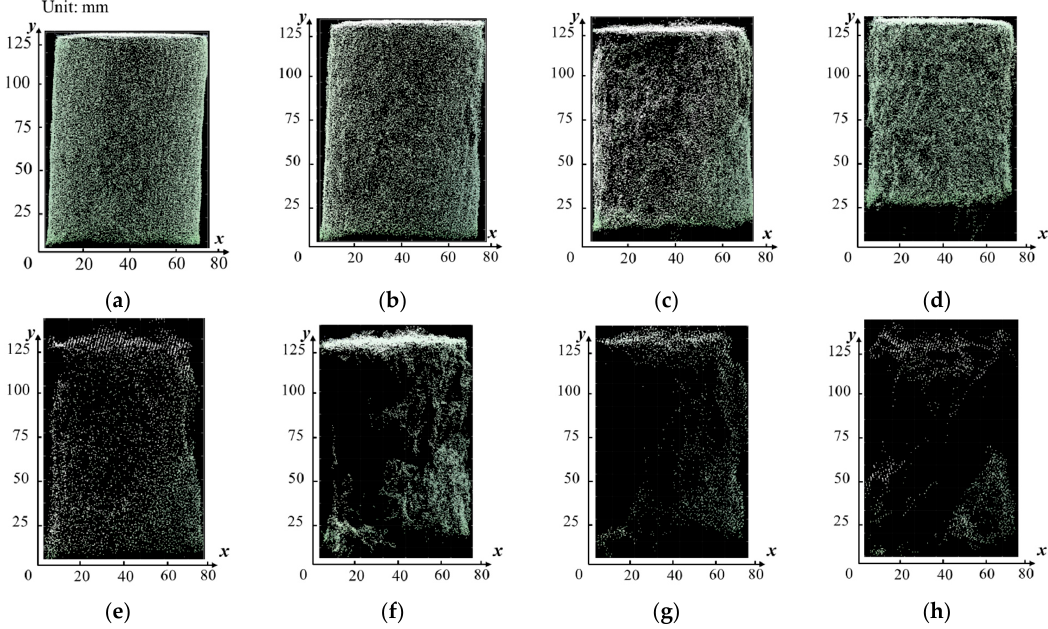
Figure 6. Comparison of the side view of O2 under different POU s. Subfigures ( a – h ) are the side view of O2 under POU of 556, 278, 168, 111, 84, 56, 28, and 17, respectively. of O2 under POU of 556, 278, 168, 111, 84, 56, 28, and 17,